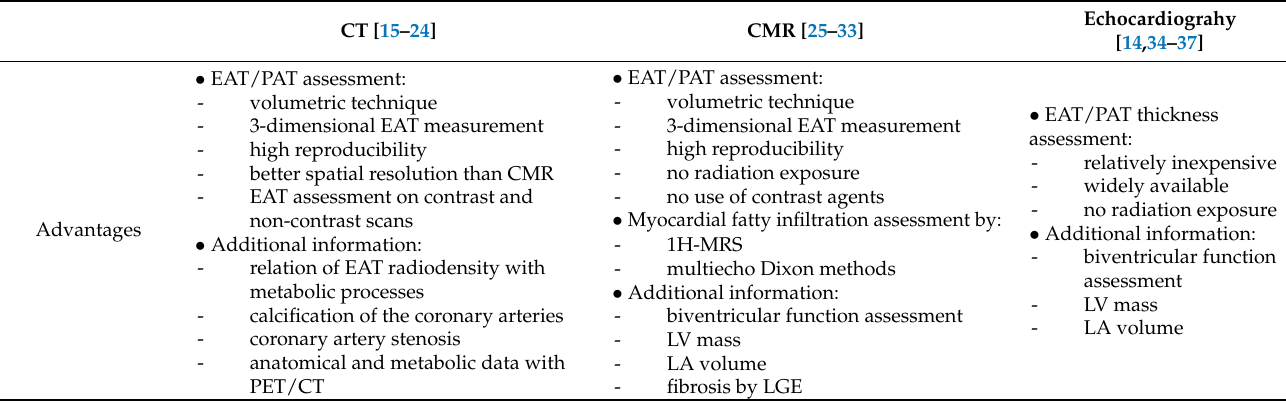
Table 1. Cardiac adiposity screening by imaging modalities. Advantages, limitations and clinical implications apart from